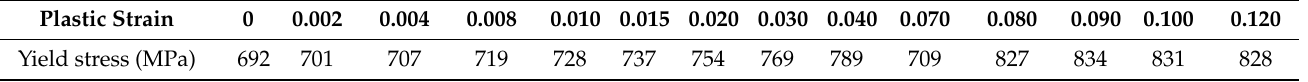
Table 5. Elastoplastic material parameters in the finite element model.